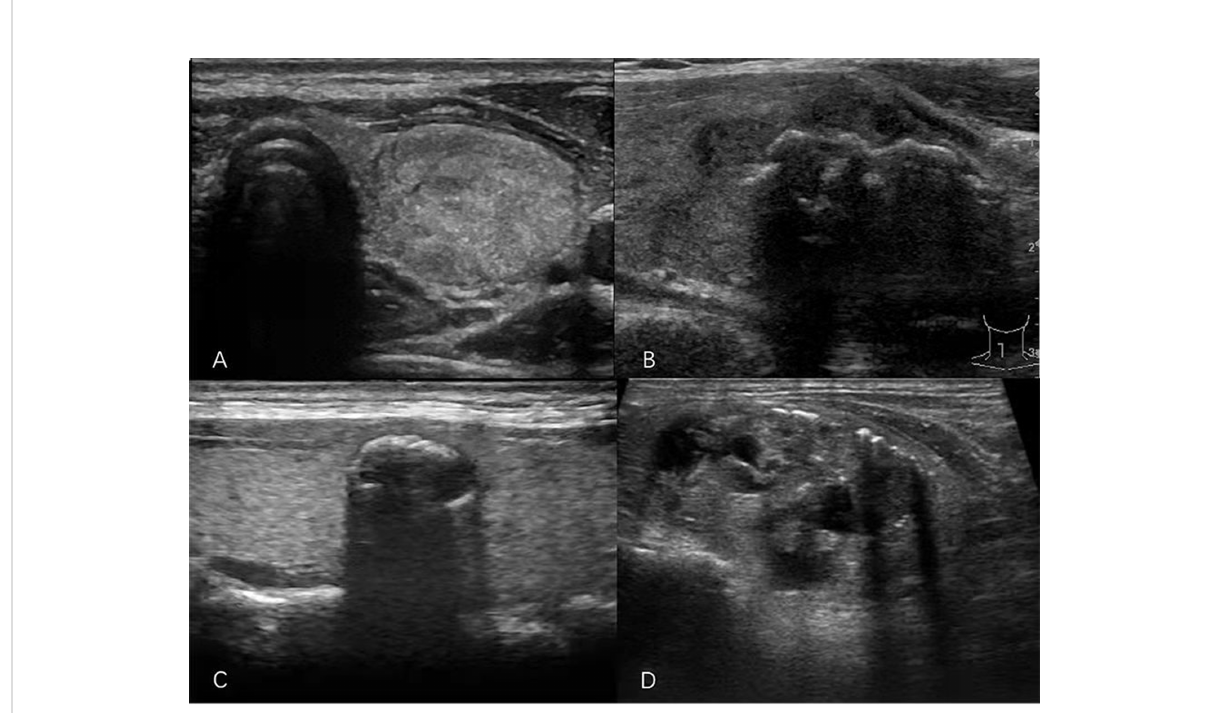
FIGURE 2 Sonograms of thyroid nodules showing different patterns of echogenic foci. (A) Punctate echogenic foci. (B) Macrocalci fi cation. (C) Peripheral calci fi cation. (D) Multiple different calci fi cation